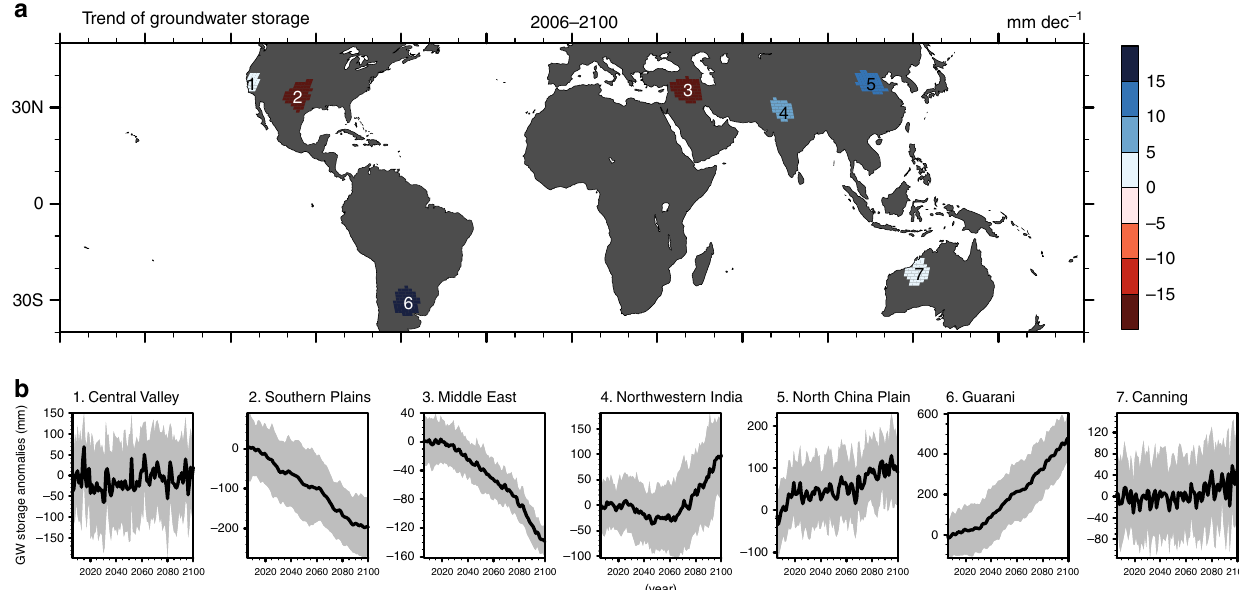
Fig. 2 Trend of groundwater storage. a The projected trends (2006 − 2100) of the climate-driven GWS changes under the RCP8.5 scenario. b The corresponding annual time series of GWS anomalies relative to the present (2006 − 2015) period. The shading denotes the range of one standard deviation among 30 ensemble